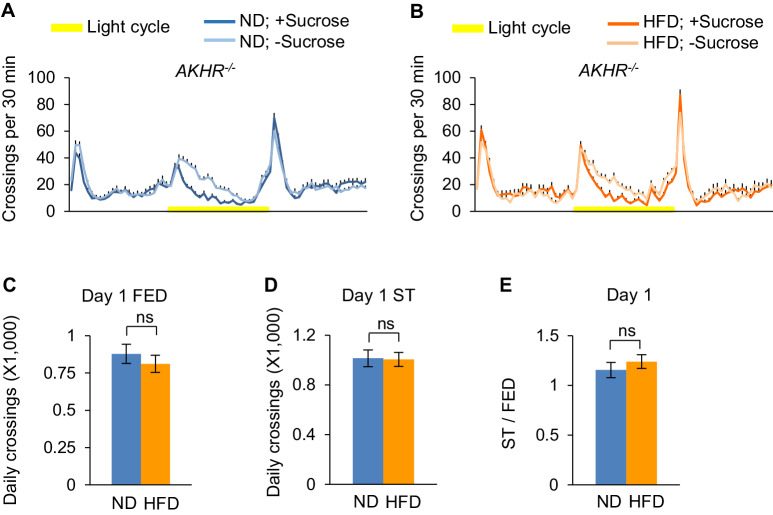
AKHR gene is required for the enhancement of starvation-induced hyperactivity by HFD.(A–B) Midline crossing activity of ND- and HFD-fed AKHR-/- flies assayed in the presence or absence of 5% sucrose (n = 43–73). (C–D) Average daily midline crossing activity of fed flies (C) and starved flies (D) assayed in A-B. (E) Starvation-induced hyperactivity of flies assayed in A-B. ns, p > 0.05. Student’s t-test was used for pair-wise comparisons.